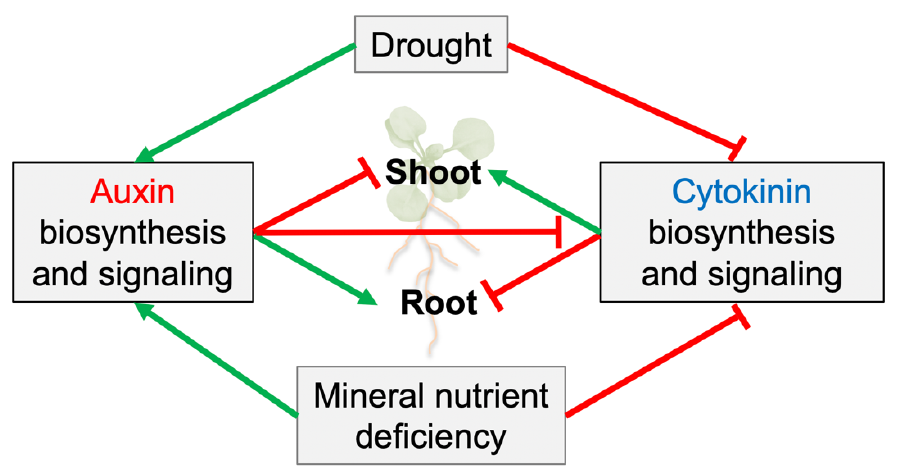
Figure 4. Schematic summary of the antagonistic cytokinin/auxin control of the shoot/root ratio in relation to water deficit and nutrient deficiency.